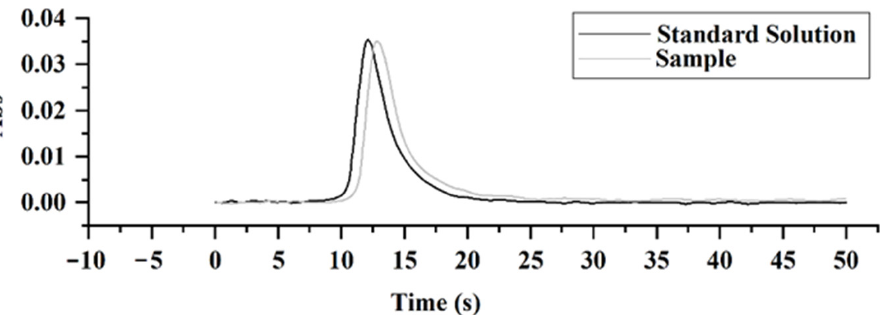
Figure 4. Optimization of H 2 and air flow rates during the vaporization and detection procedures. Herein, the CRM of peanut powder (GBW(E)100718) was measured by the ETV-AAS using different H 2 and air flow rates. Other experimental conditions were performed as shown in Table 1. The Cd intensity under 120 mL/min air + 300 mL/min H 2 was set as 1, and others were normalized with